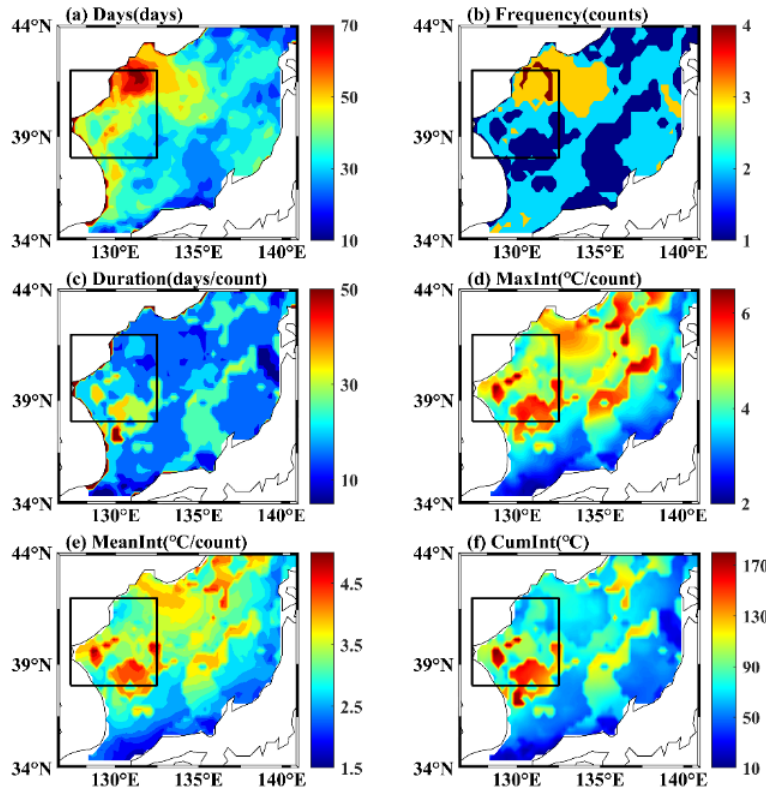
Figure 4. Same as Figure 2, but for 1 June to 31 August 2021.